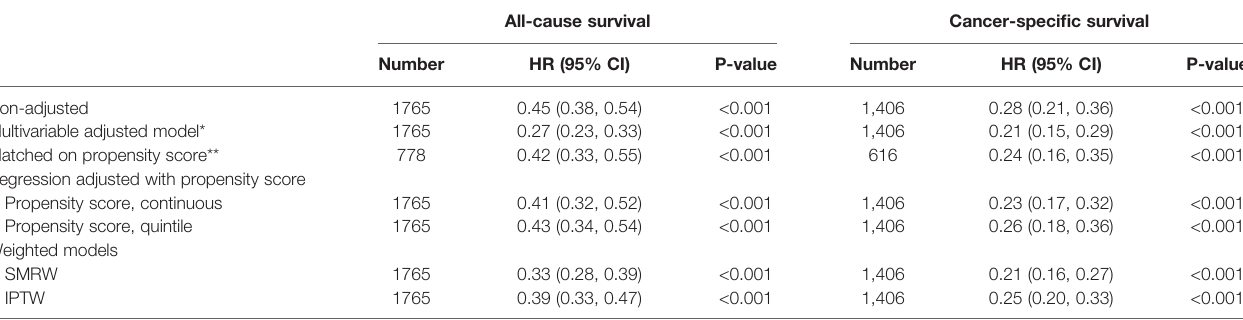
TABLE 3 | Association of surgical methods with patient overall